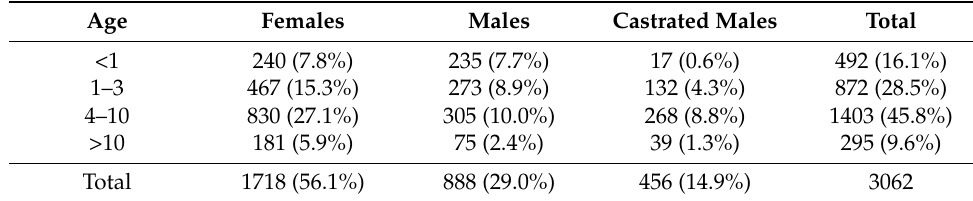
Table 2. Age and sex distribution of alpacas ( n = 3062) on 220 farms.